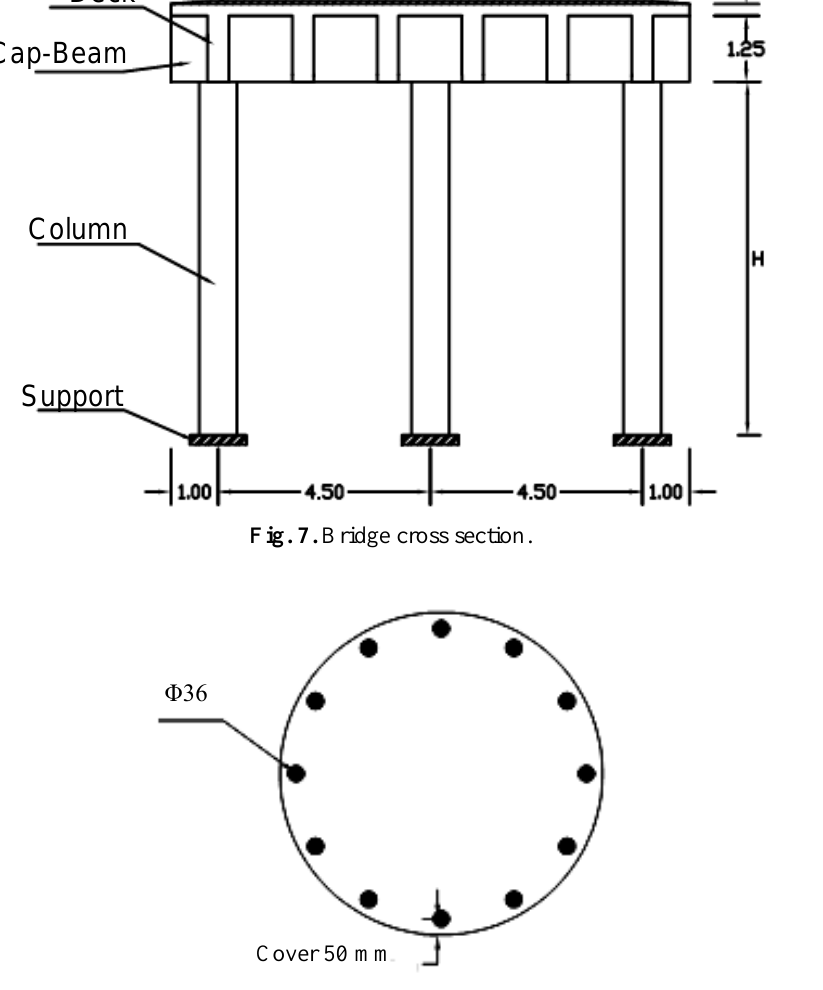
Fig. 8. Typical cross-section shapes of bridge pier. Table 1. The support stiffness for the analytical